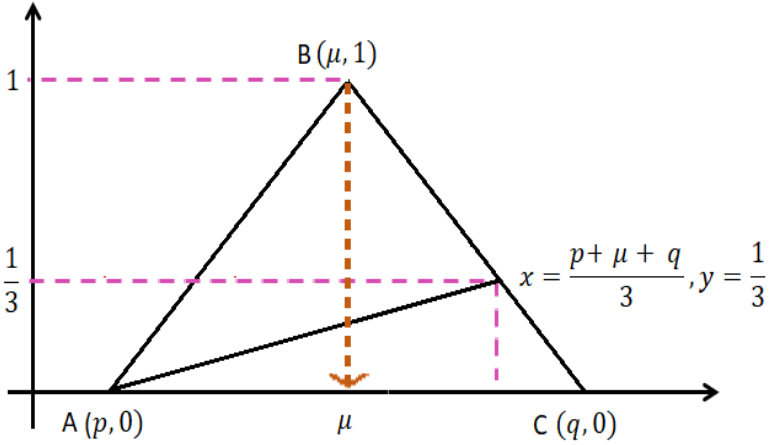
Figure 1. A triangle with a centroid to represent TrFN.